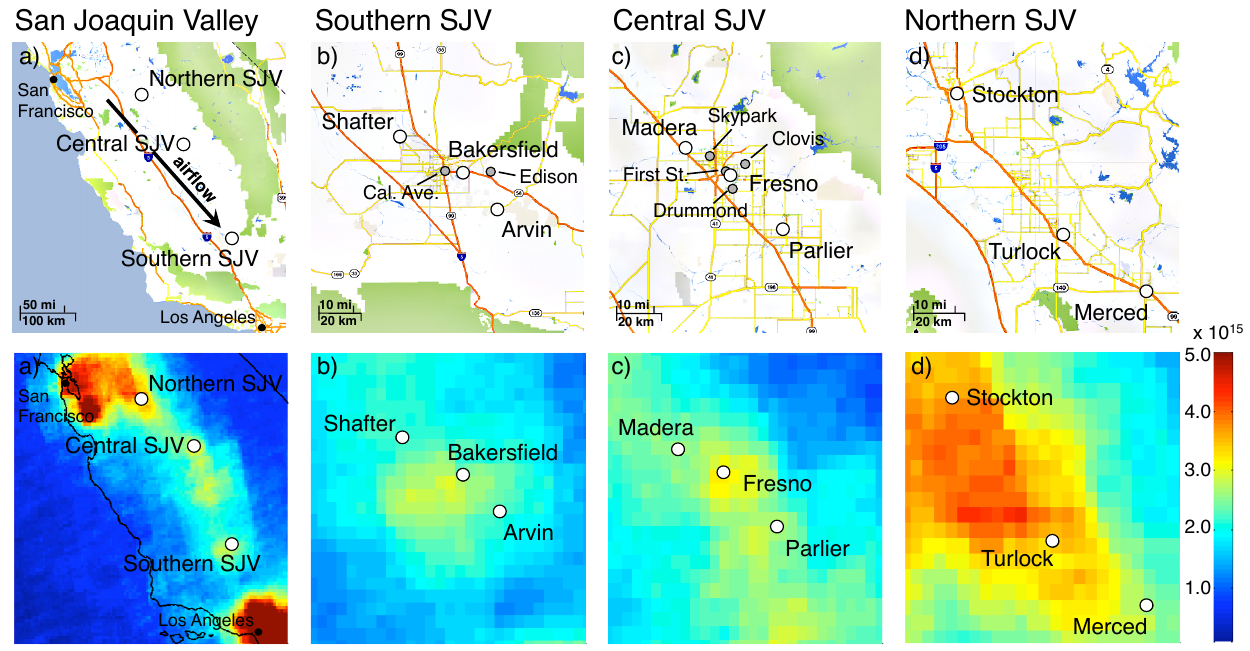
Fig. 3. Map of the California San Joaquin Valley (SJV) (a top) and details of each region for this study: Southern SJV (b top) , Central SJV (c top) , and Northern SJV (d top) . CARB 8-h maximum average O 3 and NO 2 * data are used from thirteen CARB sites: Shafter (upwind), Bakersfield, and Arvin (downwind) (white circles), where Bakersfield is the median of the California Avenue and Edison stations (grey circles); Madera (upwind), Fresno, and Parlier (downwind) (white circles), where Fresno is the median of the Skypark, First Street, Drummond, and Clovis stations (grey circles); Stockton (upwind), Turlock, and Merced (downwind) (white circles). OMI NO 2 columns (molecules cm − 2 ) are shown over the same regions. These images are June–August weekday averages from 2007–2010 for the California San Joaquin Valley (a bottom), Southern SJV (b bottom) , Central SJV (c bottom) , and Northern SJV (d bottom) .